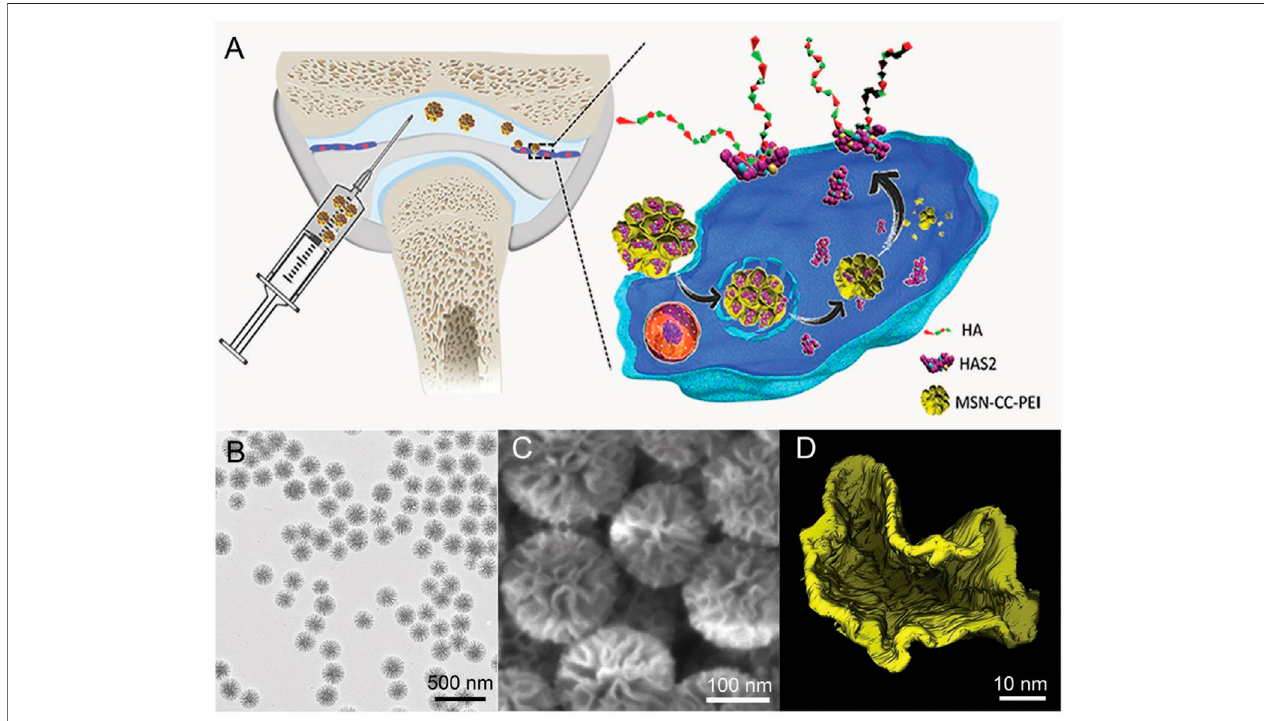
FIGURE 4 | Illustration of the cellular delivery of HAS2 to synoviocytes using nanoparticles (A) . Representative image of the nanoparticles examined with TEM (B) , SEM (C) , and the reconstructed pore structure by electron tomography (ET) technique (D) . Reproduced with permission (Li et al., 2019). Copyright 2019, Wiley- Blackwell.